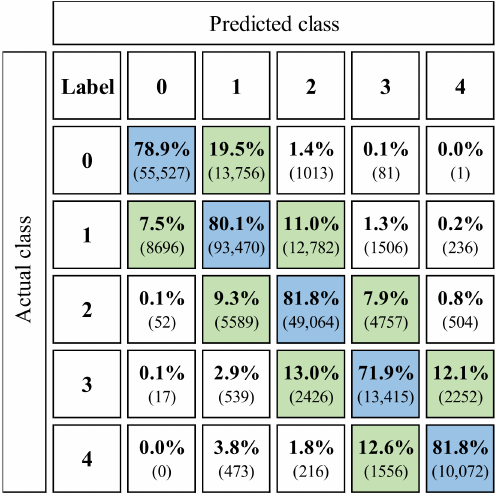
Figure 8. Confusion matrix of the test set (prediction accuracy =